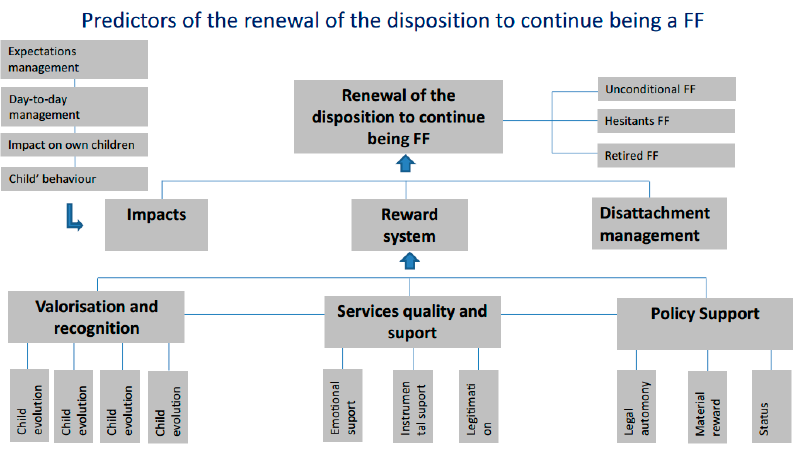
Figure 3. Predictors of the Renewal of the Disposition to Continue Being a Foster Family.